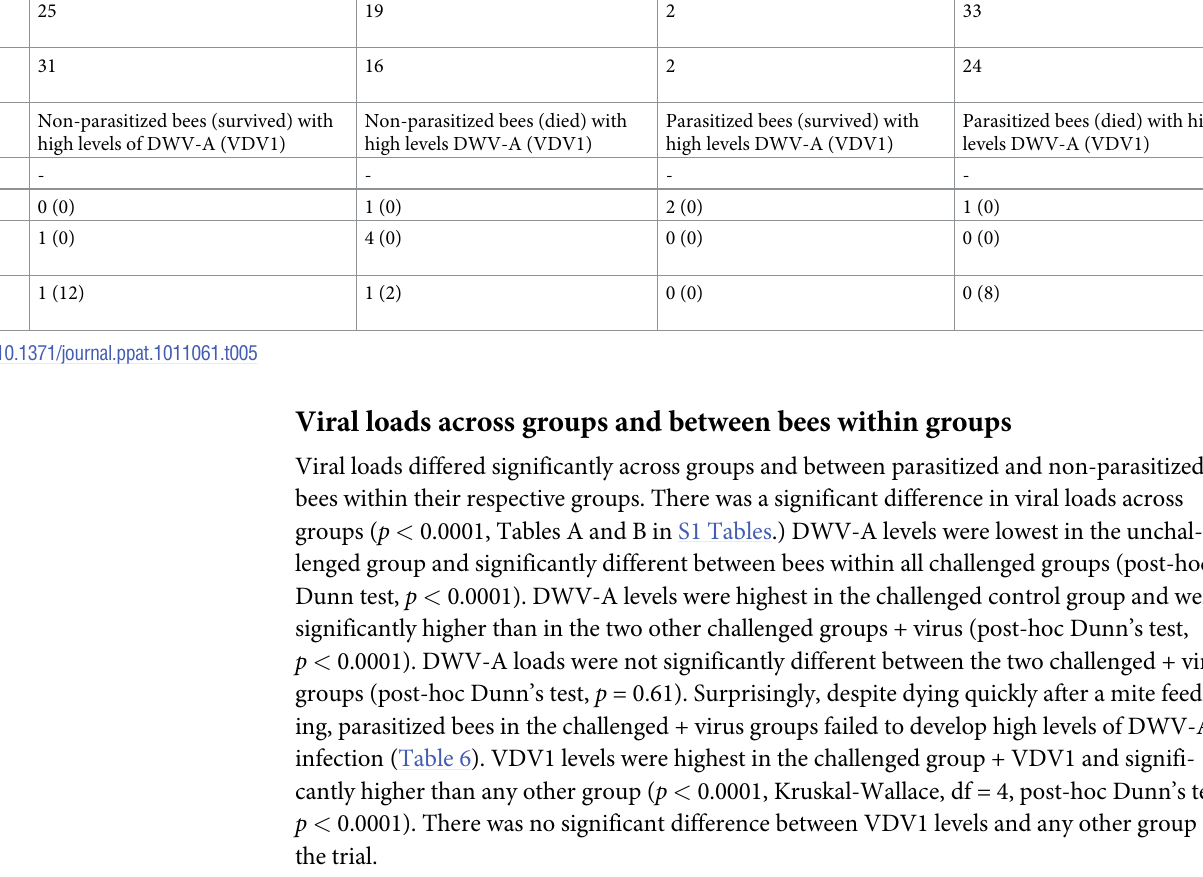
Table 5. Counts of parasitized and non-parasitized bees during experiment 4. Count data provided for parasitized and non-parasitized bees in Experiment 4. Group